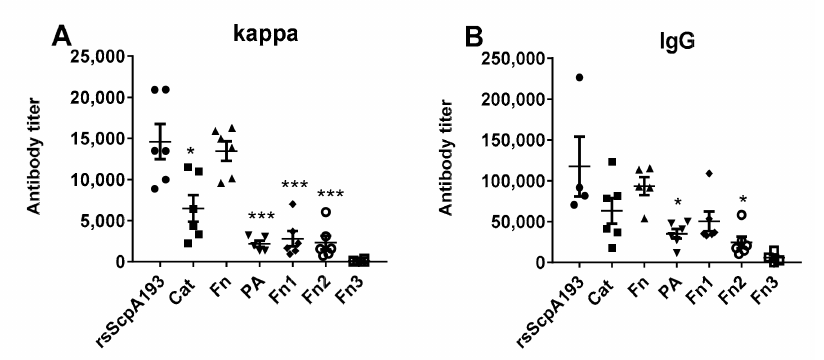
Figure 5. ELISA results of ( A ) total (anti-kappa) and ( B ) total IgG antibody titers in the pooled day 35 antisera detected with rsScpA protein as the capture antigen. Each dot represents the result of an individual mouse immunized with rsScpA193 ( • ), Cat ( (cid:4) ), Fn ( (cid:78) ), PA ( (cid:72) ), Fn1 ( (cid:7) ), Fn2 ( ( (cid:3) ), respectively; the black bars show the mean ± SEM values. *: Significantly different ( p < 0.05); ***: extremely significantly different ( p < 0.001) from the data of antiserum